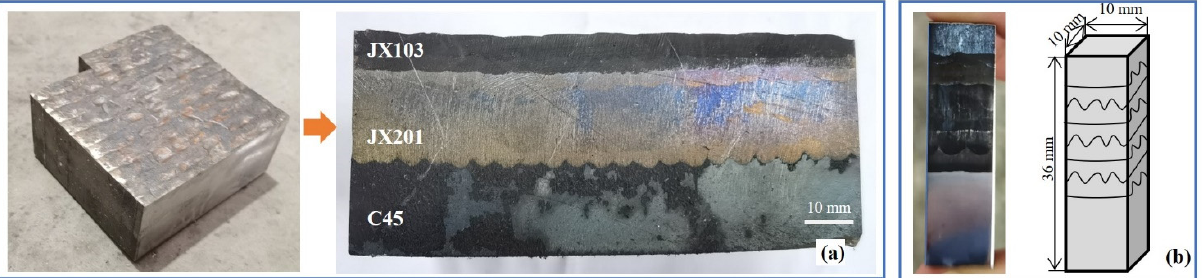
Figure 1. ( a ) Additively manufactured block sample (100 × 100 × 36 mm 3 ). ( b ) The sample for micro-